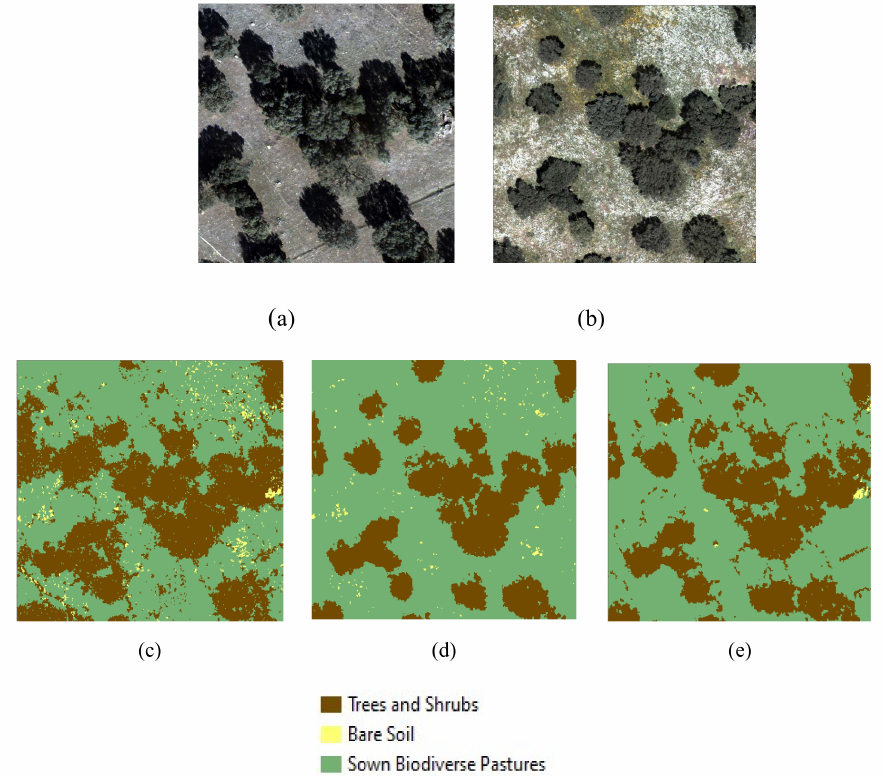
Figure 7. Extract of the aerial photograph of farm 3 in the 15th of May, 2018 ( a ) and respective results from multitemporal classification using Artificial Neural Networks ( b ), Support Vector Machine ( c ), and Random Forest algorithms ( d